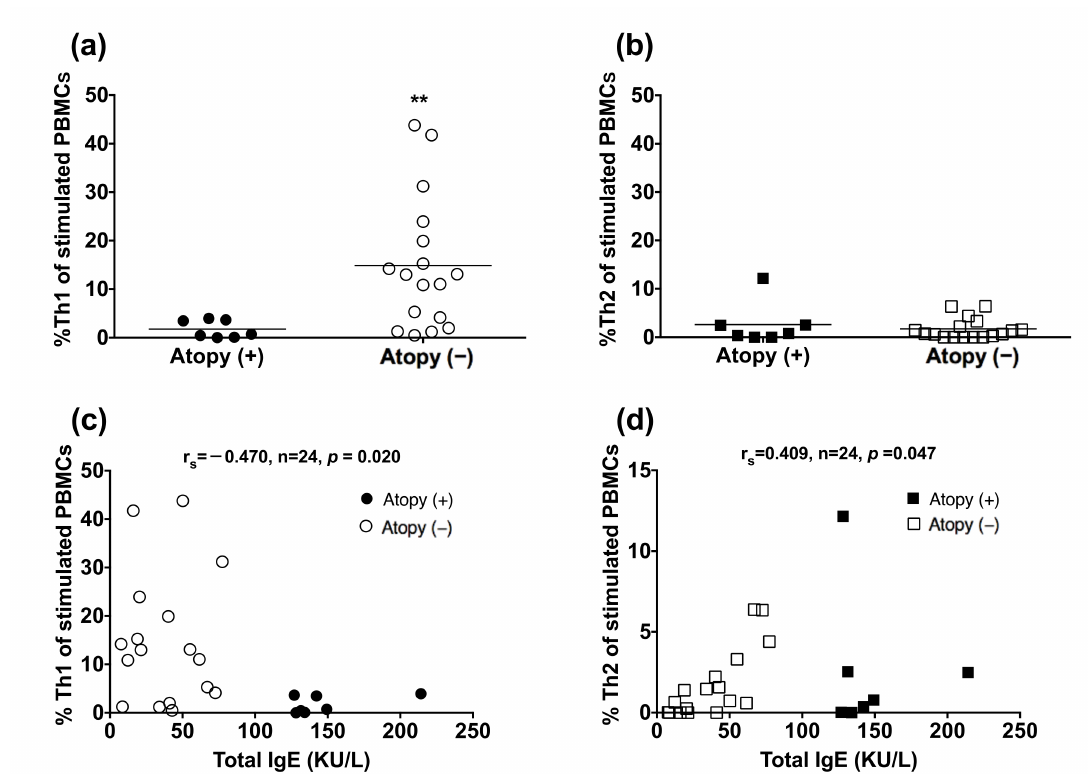
Figure 4. Reduced peripheral blood Th1 cells in the atopic patients. Peripheral blood mononuclear cells from TB-infected patients were stimulated with phorbol myristate acetate and ionomycin. CD4 + /IFN- γ + Th1 cells and CD4 + /IL-4 + Th2 cells were identified by flow cytometry: ( a , b ) values are shown as individual data points and medians. The difference between cell profiles in the atopic and non-atopic patients was determined by a paired t -test; ( c , d ) The association between the total IgE level and the proportion of Th1 cells or Th2 cells was determined by Spearman’s rank correlation. ** p < 0.01. %Th1, percentage of type 1 CD4 + T helper cells; %Th2, percentage of type 2 CD4 + T helper cells; Ig, immunoglobulin; TB, tuberculosis; IL-4, interleukin-4; IFN- γ , interferon- γ .